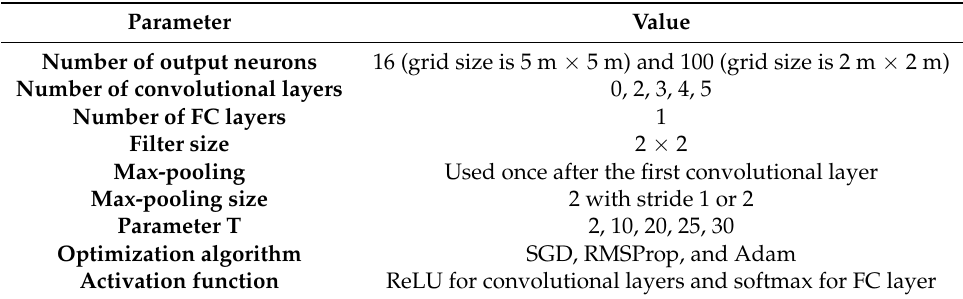
Table 1. List of the proposed hyperparameters.